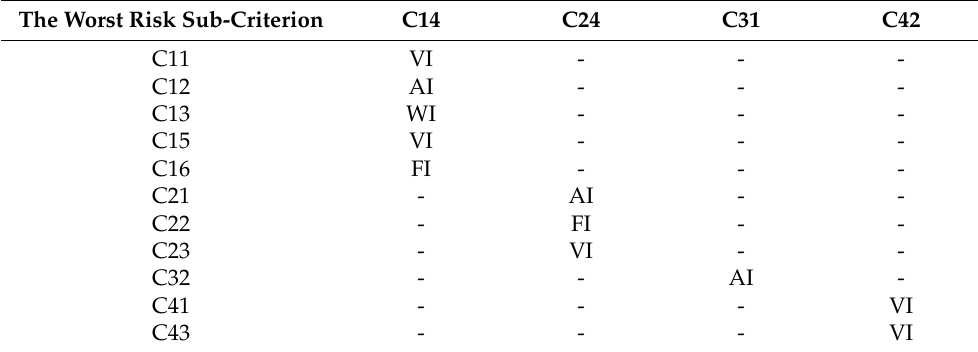
Table 6. The linguistic terms for fuzzy preferences of other risk sub-criteria over the worst risk